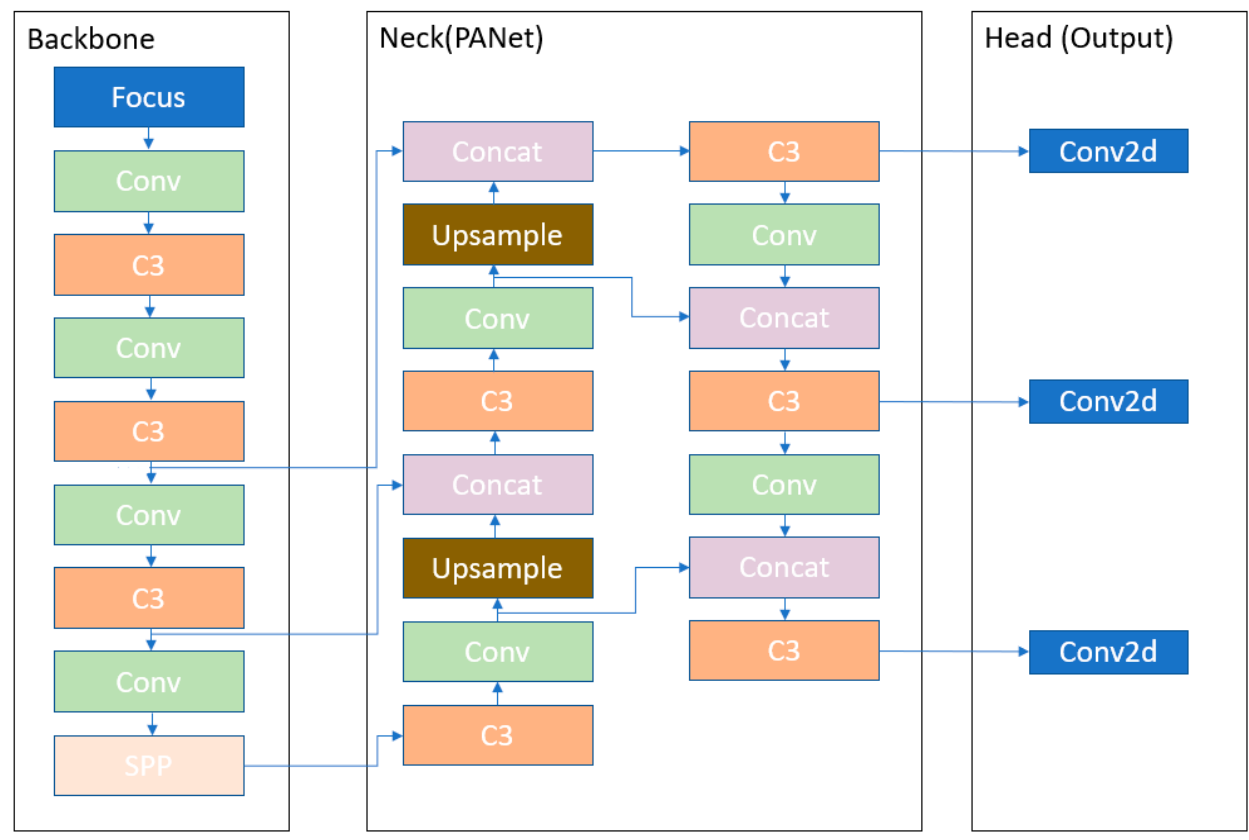
Figure 3. YOLOv5 Architecture.